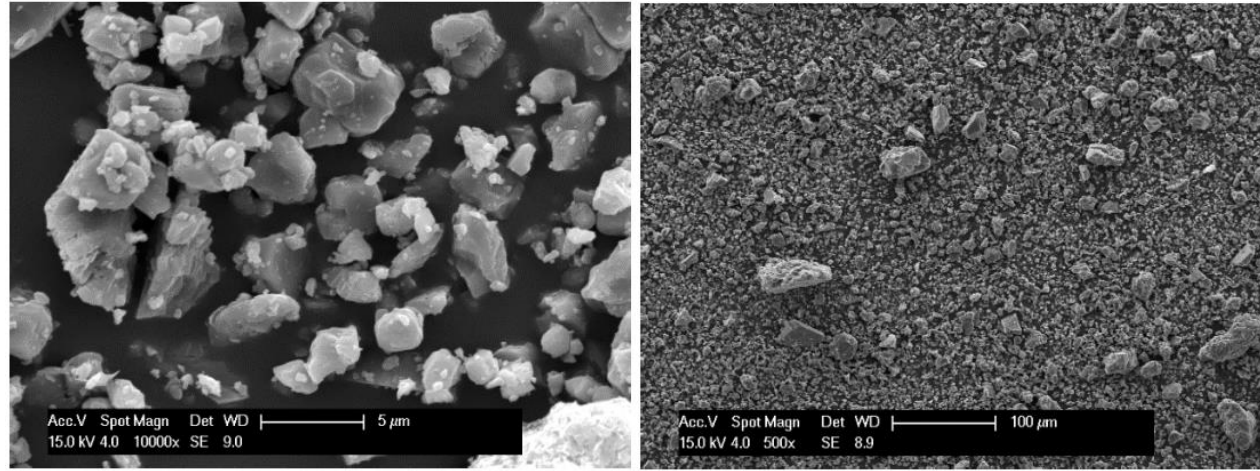
Figure 4. SEM image of limestone filler.